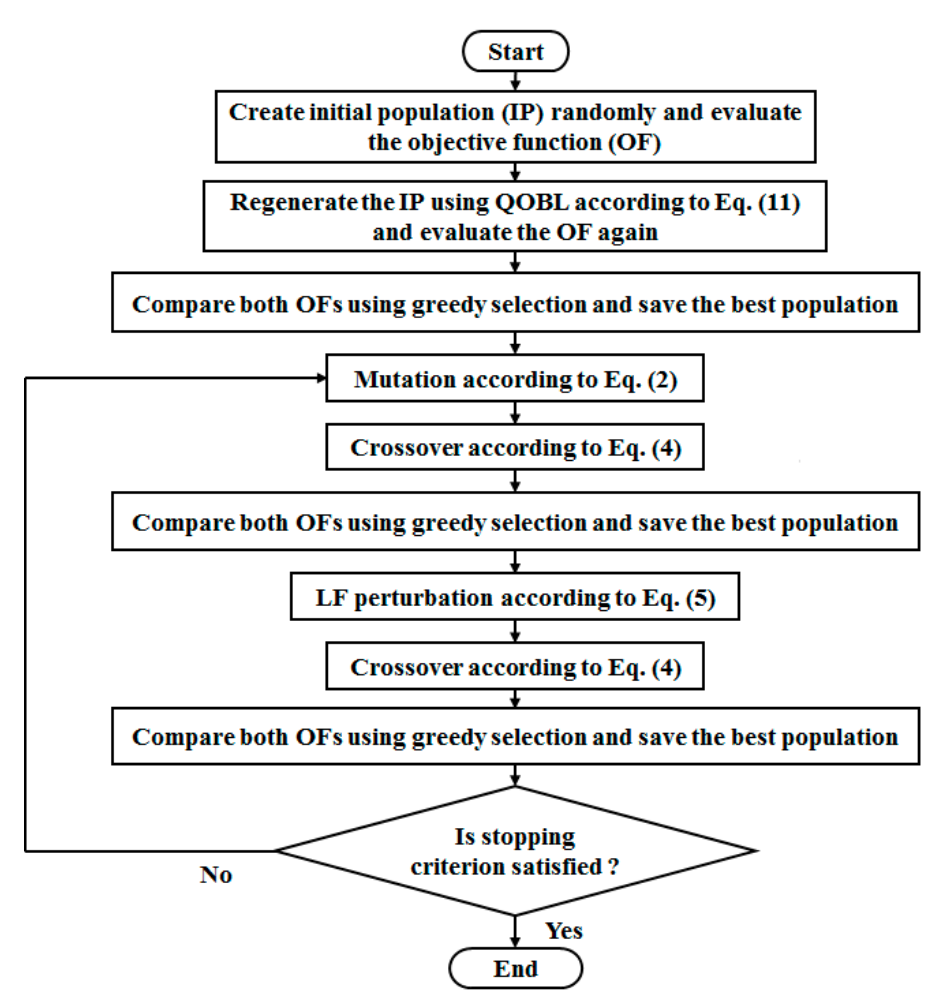
Figure 1. Flowchart of the quasi-oppositional differential evolution Lévy flights algorithm (QODELFA).